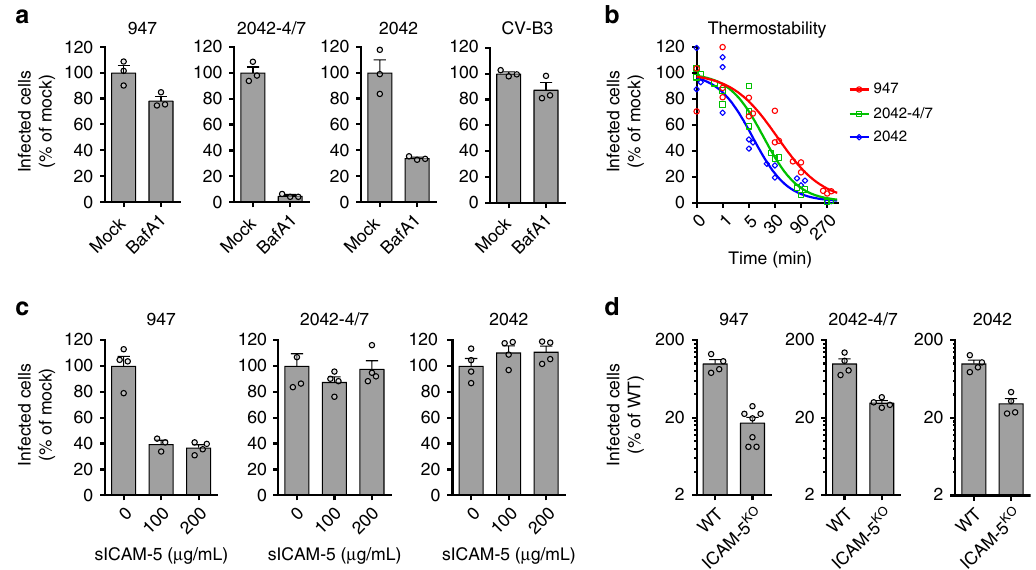
Fig. 3 EV-D68-947 is acid-independent and has altered ICAM-5-binding properties. a HeLa-R19 cells were treated with 200 nM ba fi lomycin A1 (BafA1), infected and stained for dsRNA, followed by quanti fi cation of infected cells. The experiment was conducted twice with similar results. b Viruses were incubated at 48 °C for the indicated times, followed by infection of HeLa-R19 cells, dsRNA staining and quanti fi cation of infected cells. Four technical replicates with a fi tted sigmoidal curve are shown. c Viruses were incubated with soluble ICAM-5 (sICAM-5), followed by infection of HeLa-R19 cells, dsRNA staining and quanti fi cation of infected cells. The experiment was conducted twice with similar results. d WT or ICAM-5 KO HAP1 cells were infected and stained for dsRNA, followed by quanti fi cation of infected cells. Error bars represent the mean ± s.e.m. of three ( a , b ) or four ( c , d ) technical